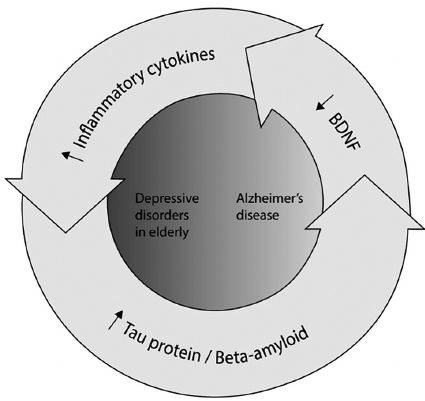
Figure 1. The complex interplay of biomarkers in the depressive disorders – Alzheimer’s disease